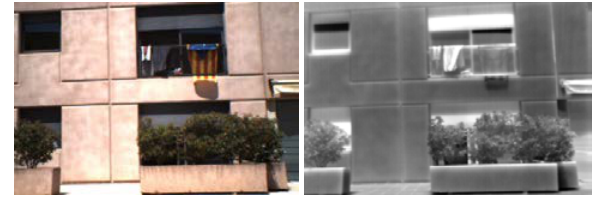
Figure 3. The average results of 44-pair multimodal images in CVC dataset with different